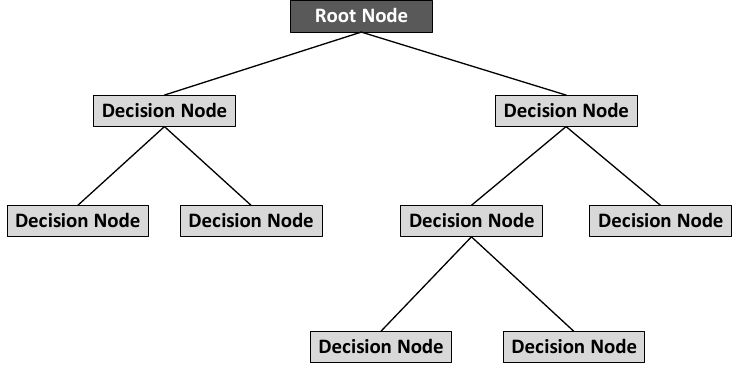
Figure 12. Depiction of Decision Tree Structure.